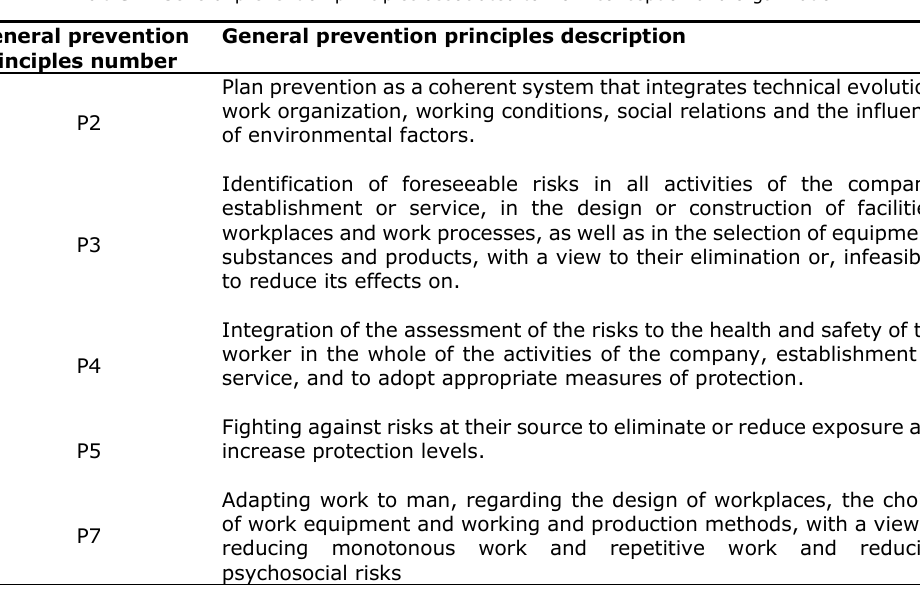
Table 2. General prevention principles associated to work conception and organization